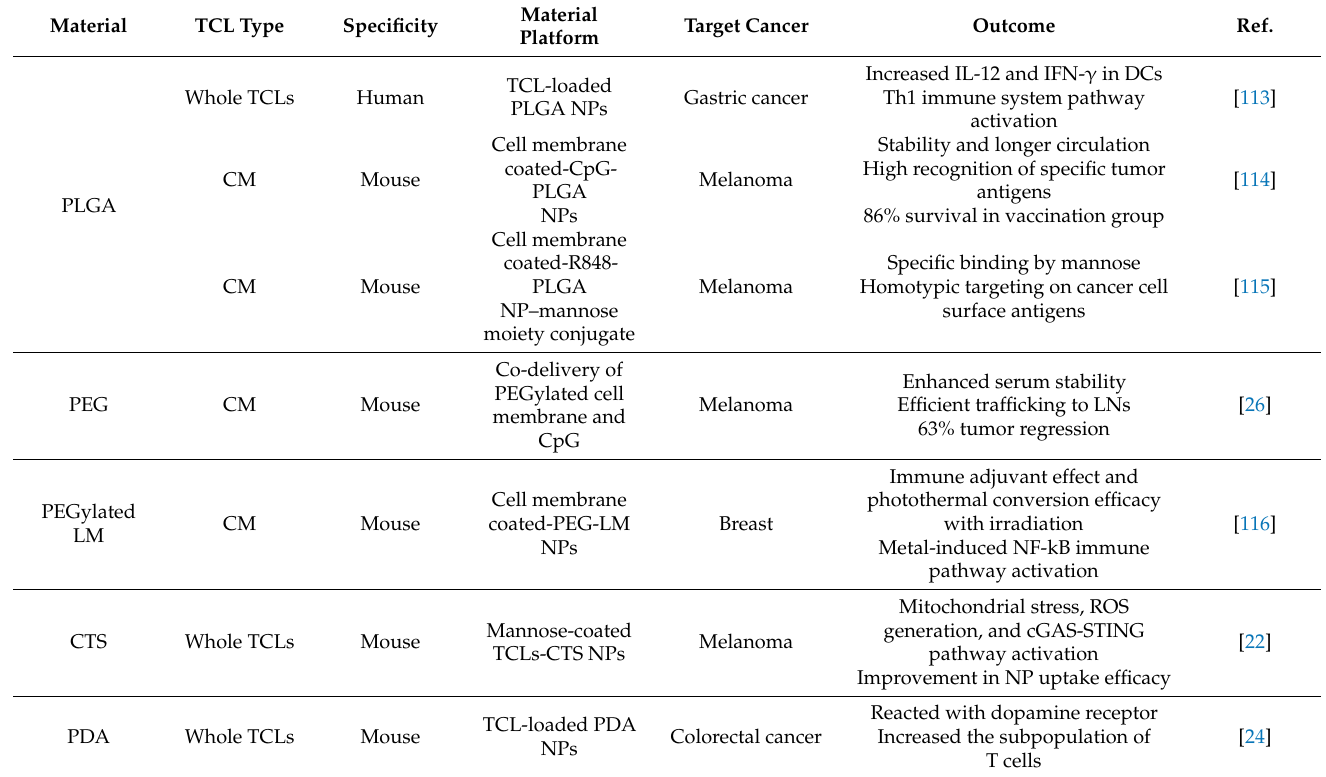
Table 2. Polymer-based material delivery platforms for exogenous TCL